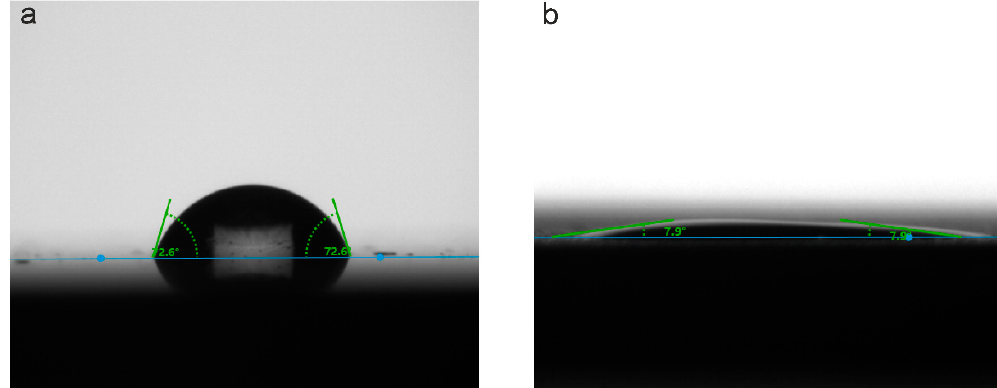
Figure 10. Drops form and contact angle values for uncoated sample ( a ) and sample with a PEO-coating ( b ) Test liquid is SBF.